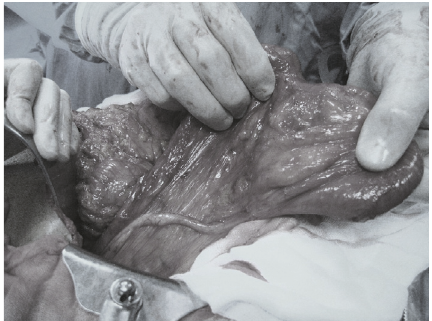
Figure 2: Elongation of the ileocolic pedicle without lateral peri- toneal attachments and with hypermobile cecal apex, which could be directed toward the upper quadrant. A retrocecal, ascending appendix can also be noticed.